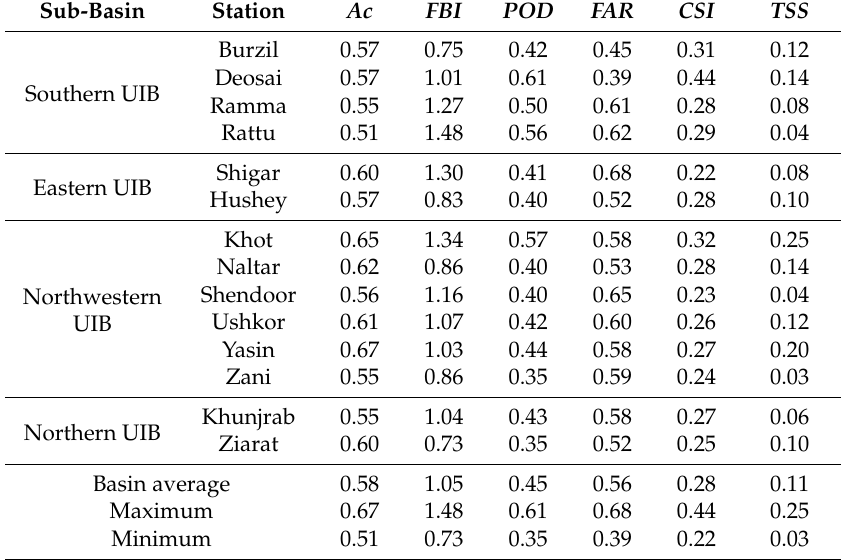
Table 6. Categorical statistics for daily TRMM estimate and gauge rain data. Ac : accuracy; FBI : frequency bias index; POD : probability of detection; FAR : false alarm ratio; CSI : critical success index; TSS : true skill